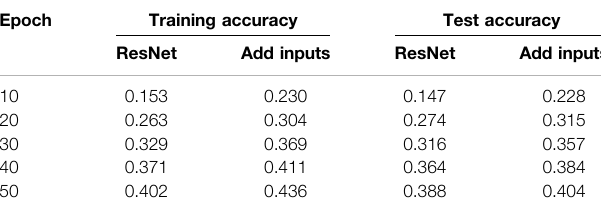
TABLE 2 | CIFAR-10 training and test accuracy average of three runs. Epoch